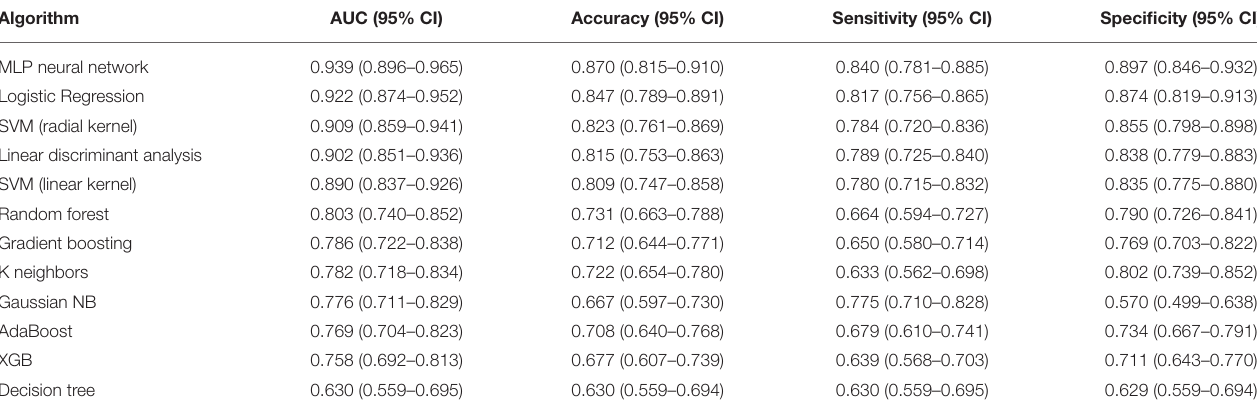
TABLE 2 | Performances of the 12 machine learning classifiers on 30-round 6-fold cross-validation in testing dataset for predicting tumor shrinkage pattern based on all the selected features. Algorithm